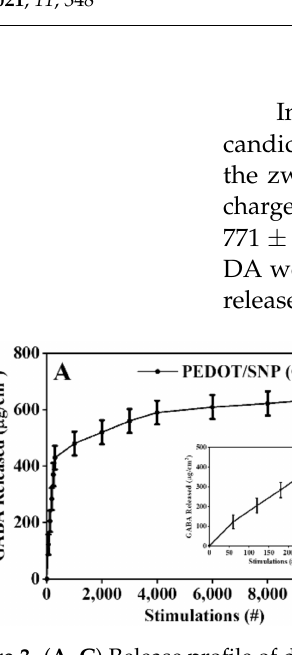
Figure 3. ( A – C ) Release profile of drug loaded microwires; the films are PEDOT/SNP (GABA), PEDOT/SNP (Bicuculline), and PEDOT/SNP (DA). Insect in panel A and B shows data from first 300 stimulations